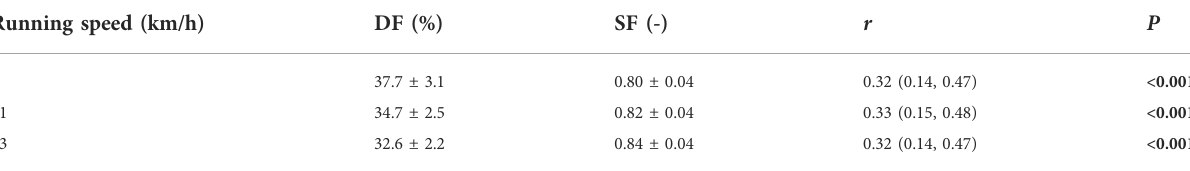
TABLE 1 Duty factor (DF) and step frequency (SF), as well as their Pearson ’ s correlation coef fi cient ( r ) together with their 95% con fi dence interval (lower, upper) and statistical signi fi cance ( P ≤ 0.05), indicated in bold, for three tested speeds. Running speed (km/h)